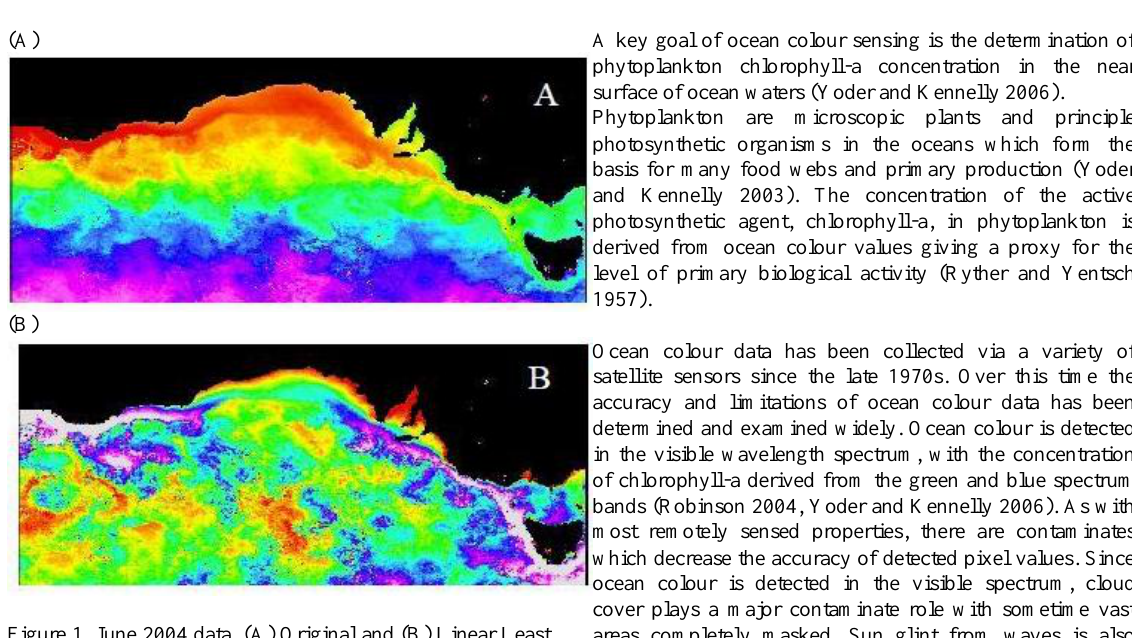
Figure 1, June 2004 data, (A) Original and (B) Linear Least Squares